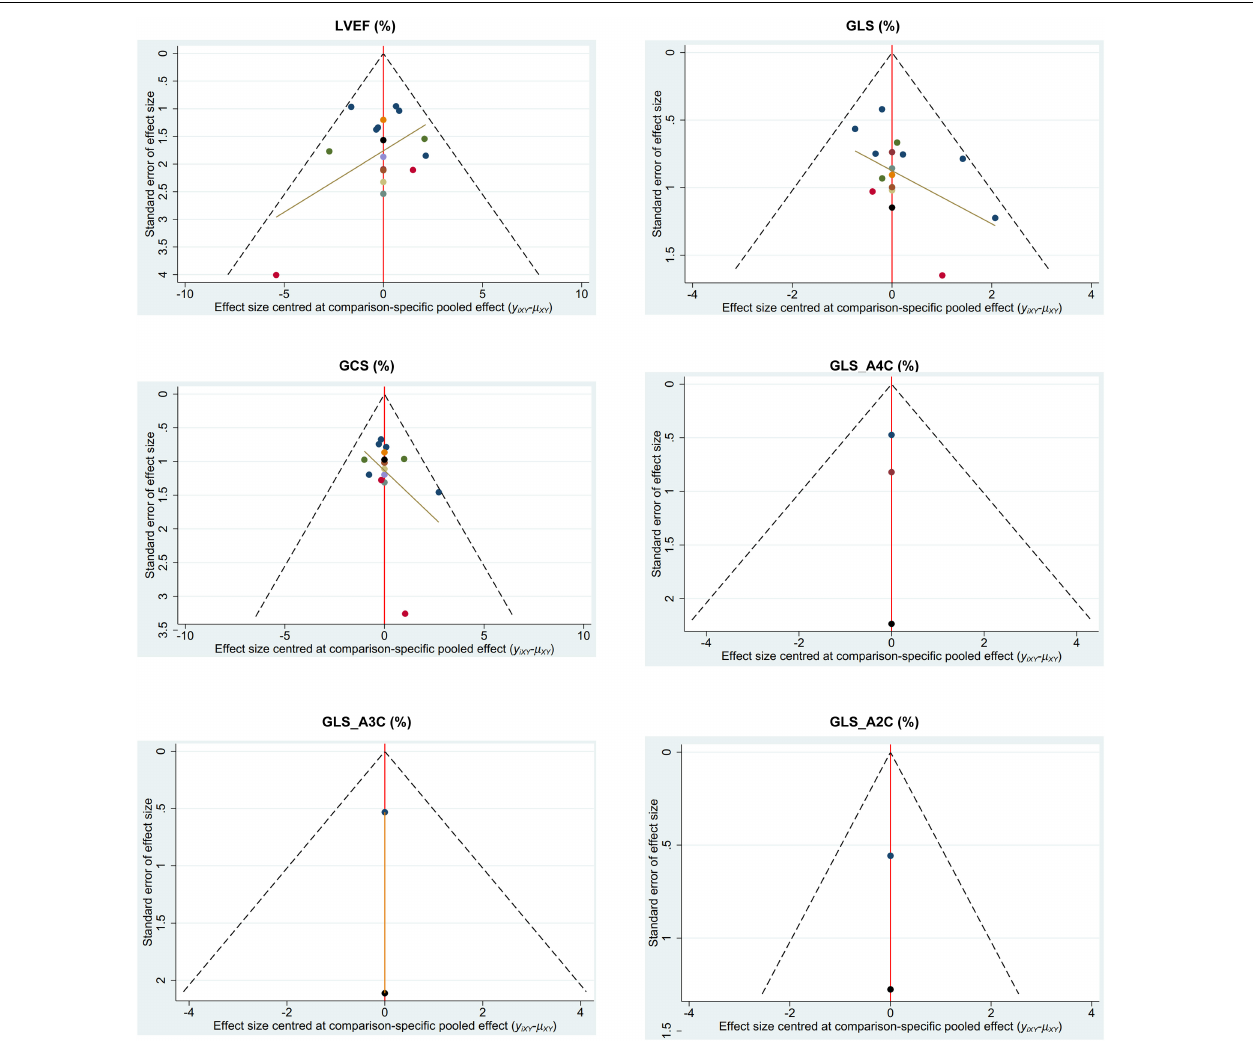
FIGURE 5 | Funnel plot of network meta-analysis. GCS, global circumferential strain; GLS, global longitudinal strain; GLS_A2C, global longitudinal strain_apical two-chamber; GLS_A3C, global longitudinal strain_apical three-chamber; GLS_A4C, global longitudinal strain_apical four-chamber; LVEF, left ventricular ejection